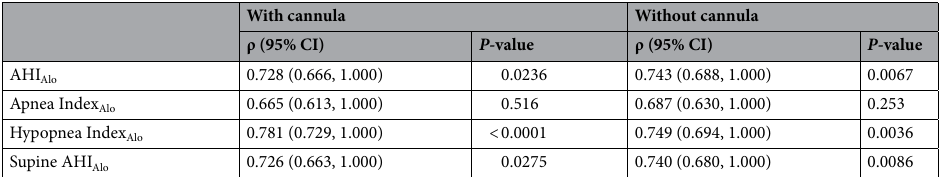
Table 3. Interclass correlation between respiratory events scored from infrared optical gas images alone (Alo data) and from PSG. AHI apnea–hypopnea index, Alo infrared alone, CI confidence interval, PSG